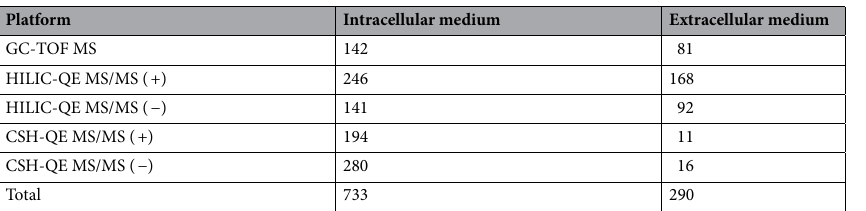
Table 1. Number of annotated metabolites in the intracellular and extracellular medium after incubation of HK-2 cells in HG (25 mM glucose)-hypoxia (1% O 2 ) and control (5.5 mM glucose/18.6% O 2 ) conditions for 48 h and using different analytical platforms and ionization